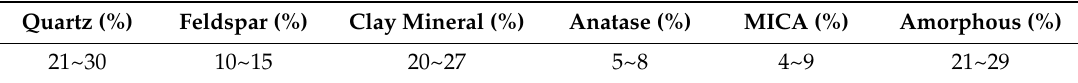
Table 3. Physical and mechanical parameters of shale